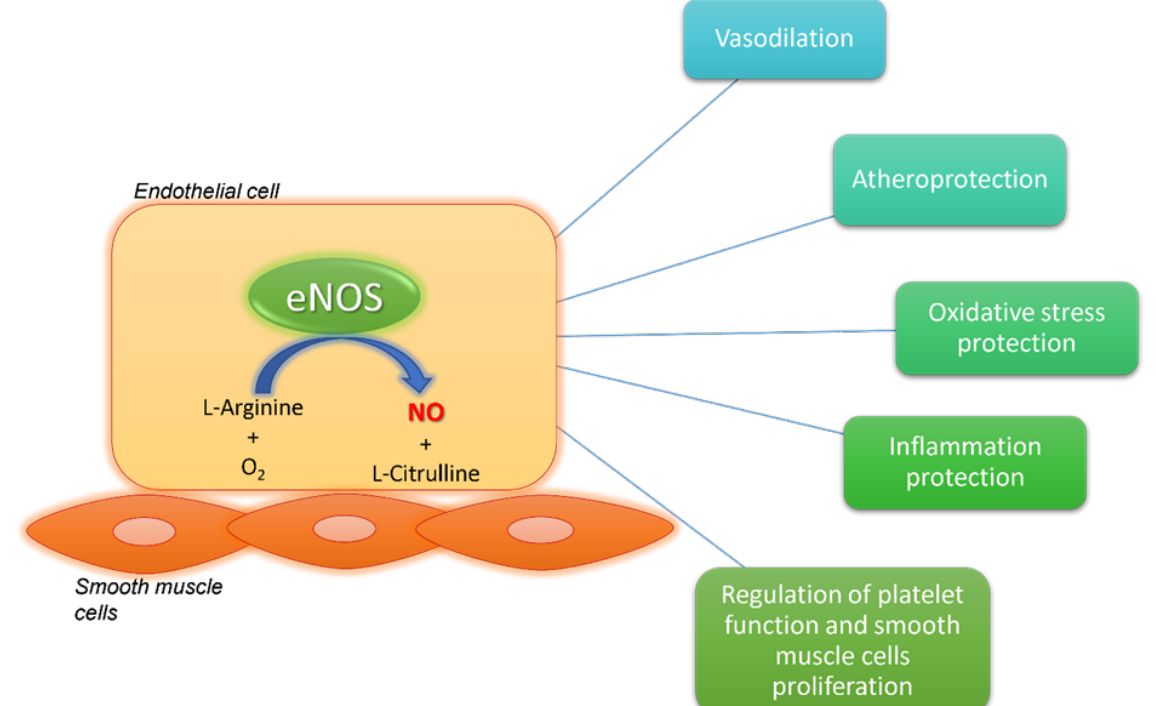
Figure 1. Endothelial nitric oxide synthase (eNOS) and nitric oxide (NO) physiological effects. eNOS produces NO starting from L-arginine and oxygen. NO has several beneficial effects on the vasculature. It is involved in atheroprotection and vasodilation. It contrasts oxidative stress, inflammation, platelet dysfunction and smooth muscle cell proliferation. eNOS: endothelial nitric oxide synthase; NO: nitric oxide; O 2 : oxygen.